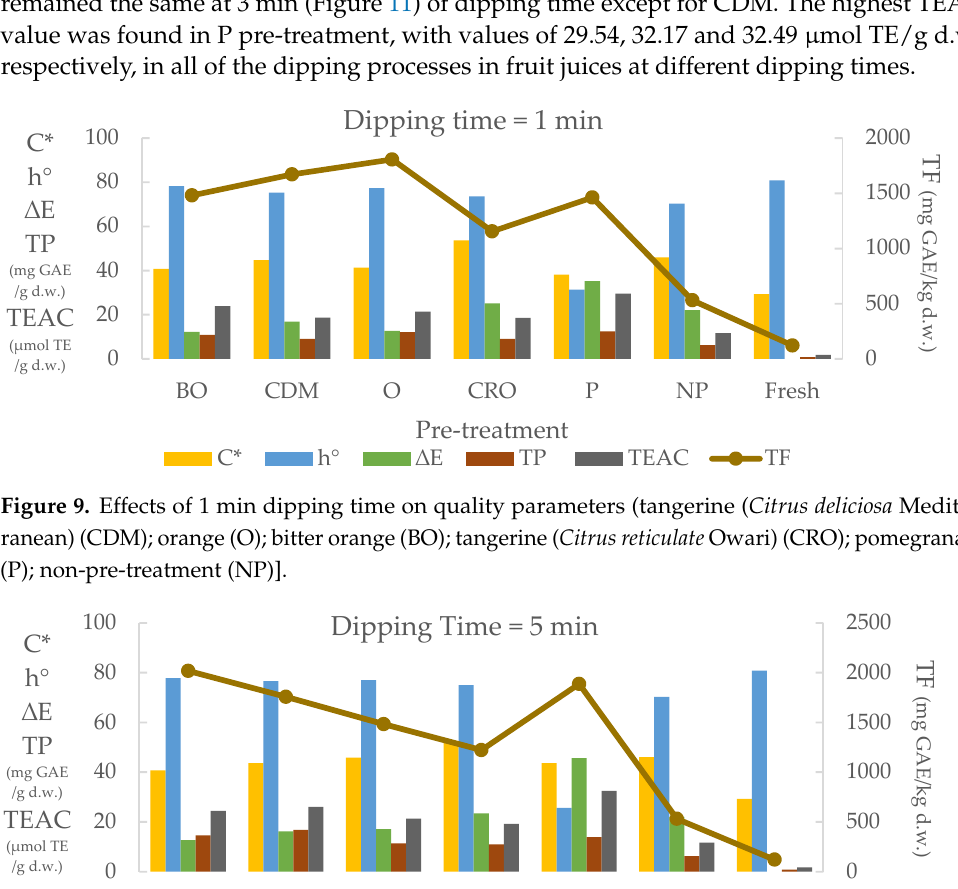
Figure 8. Effects of slice thickness on quality parameters.